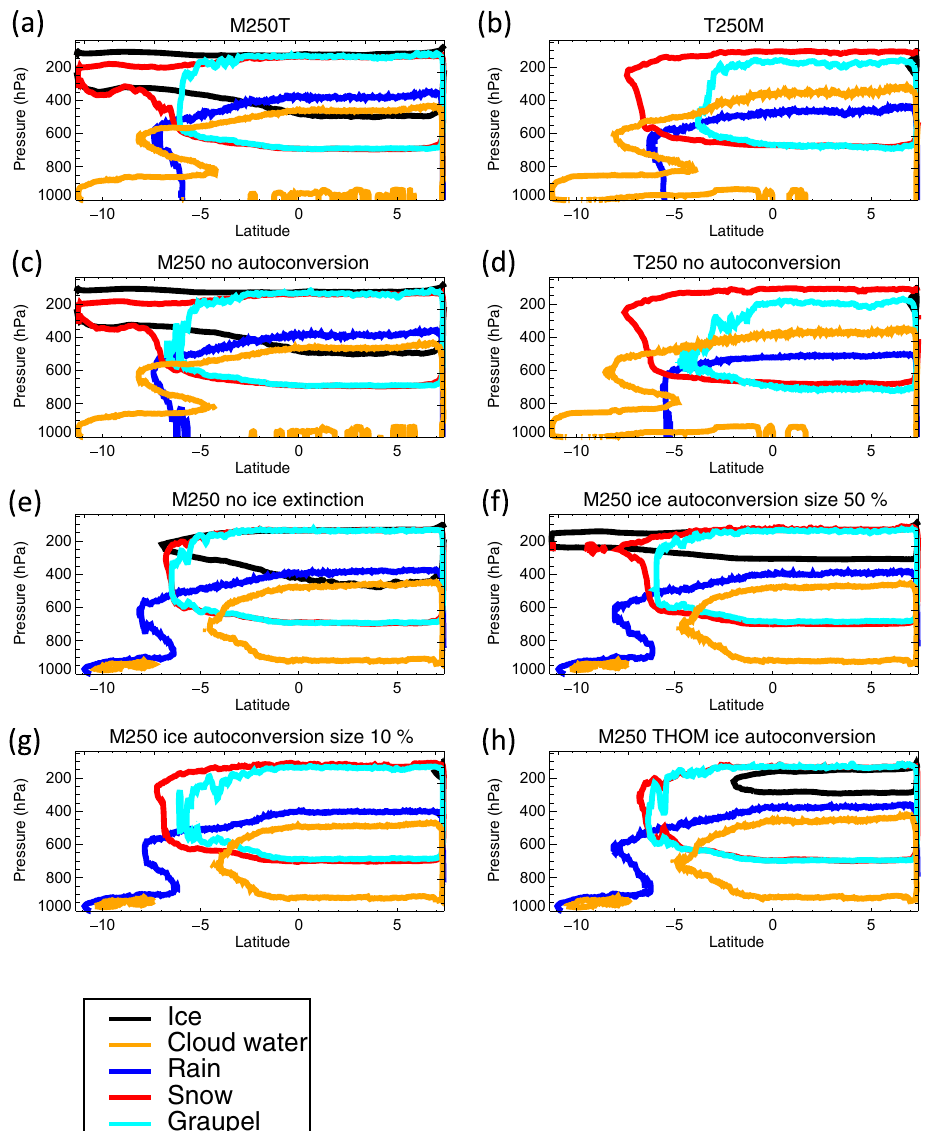
Figure 16. Congo case: zonal mean vertical sections of hydrometeor classes (colour contours) from 1 to 10 August 2007, as in Fig. 4, but for the configurations with the autoconversion treatment swapped between the microphysics schemes (a) CONGO-M250T and (b) CONGO- T250M; for the configurations with (c) CONGO-M250 with autoconversion turned off, (d) CONGO-T250 with autoconversion turned off, (e) CONGO-M250 with the ice extinction coefficient set to zero in the longwave and shortwave radiation schemes, (f) CONGO-M250 with the threshold size parameter for conversion of ice to snow reduced to 50% of its default value, (g) CONGO-M250 with the threshold size parameter for conversion of ice to snow reduced to 10% of its default value and (h) CONGO-M250 with the autoconversion of ice to snow replaced by that used in the Thompson microphysics scheme. Hydrometeor mass mixing ratios are contoured at 10 − 6 kgkg − 1